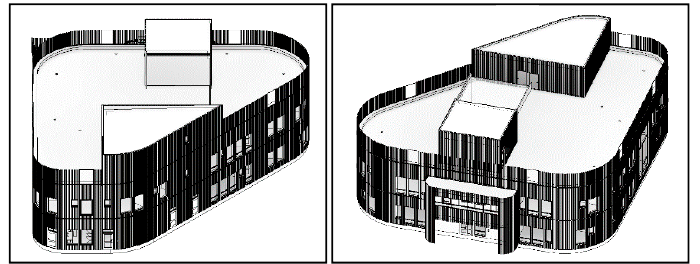
Figure 7. Kindergarten Lotsen, Revit model.